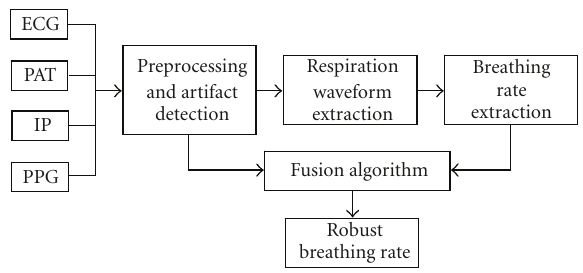
Figure 1: The proposed robust respiration rate estimation tech- nique using a signal fusion framework and signal quality